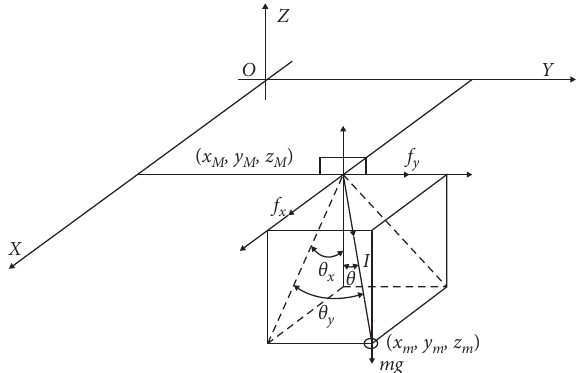
Figure 3: The system model of the concrete